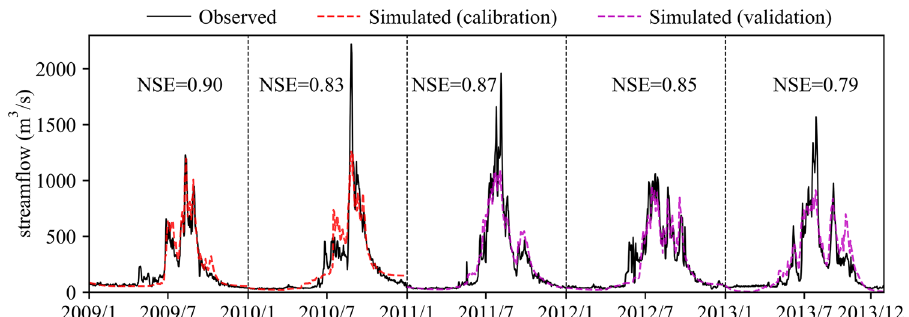
Figure 8. Results of SRM. In the calibration (2009–2010), parameters including the degree day factor − 1 ( α = 0.13 cm ◦ C − 1 day ), critical temperature (0 °C), runoff coefficient for snow ( C S = 0.3 ) and runoff coefficient of rain ( C R = 0.5 ) were determined, and NSE reached 0.9 and 0.83, respectively. These four parameters were used in the validation (2011–2013), and NSE were 0.87, 0.85 and 0.79,